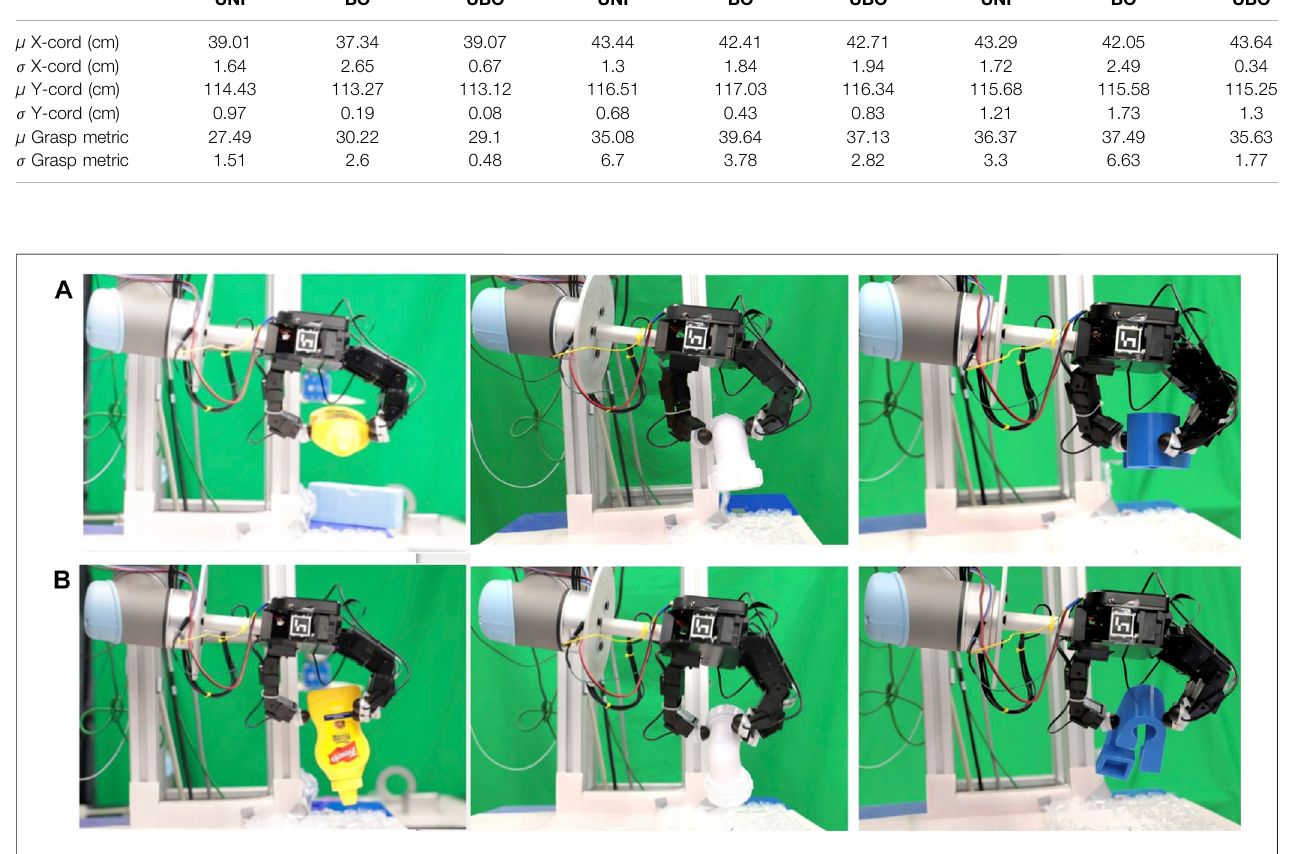
FIGURE 4 | Two states of stability observed while maintaining the object in the air: (A) stable grasp (B) partial stable grasp.